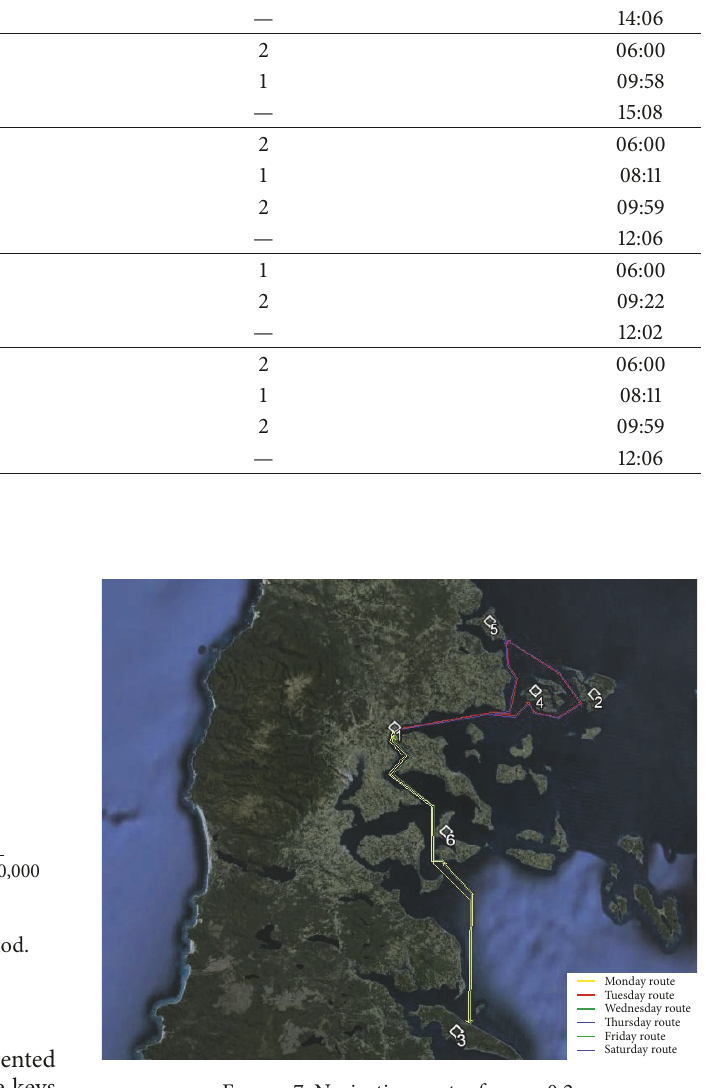
Figure 7: Navigation routes for 𝛼 =